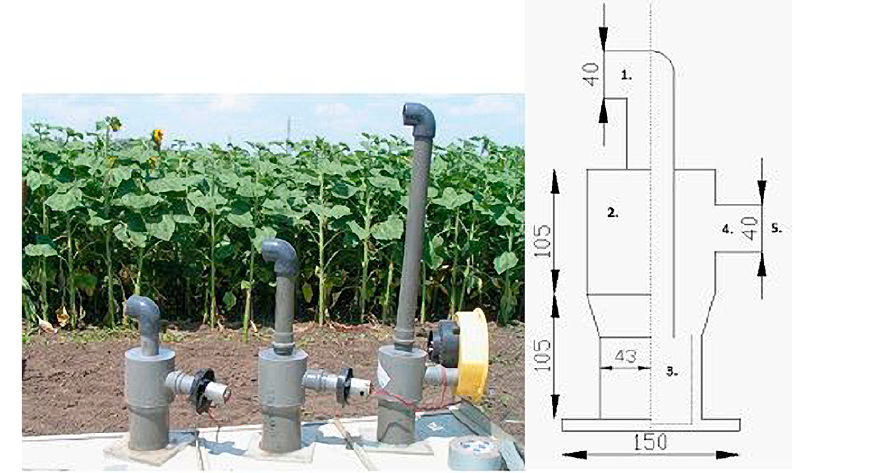
Figure 6. WAST trap and its components: 1. Inlet, 2. Trap, 3. Sampling jar, 4. Outlet, 5. Turbine extraction (values in mm) (Farsang et al.